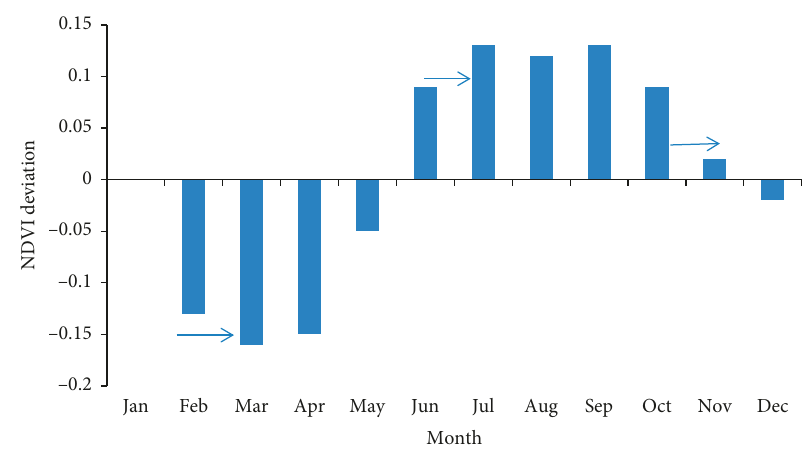
Figure 2: Long-term monthly NDVI deviations revealing vegetation growth patterns in